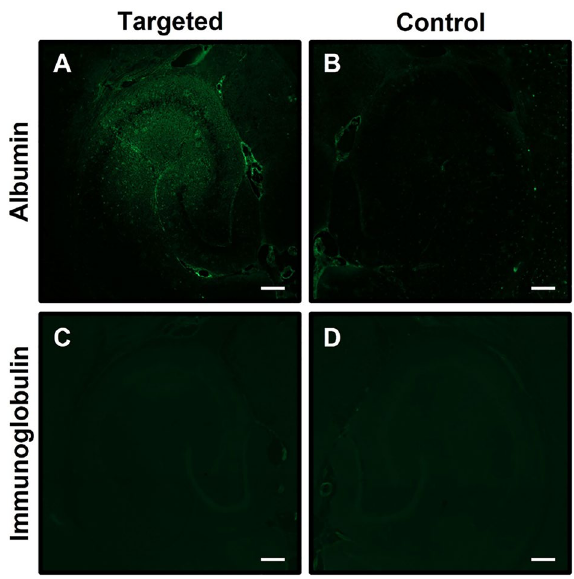
Figure 4. Assessment of endogenous albumin and immunoglobulin extravasation following RaSP treatment at 0.35 MPa. Fluorescence microscopy images of brain slices revealed fluorescence from immunostained endogenous albumin (66.5 kDa) in the ( A ) left hippocampus ROI targeted with RaSP at an acoustic pressure of 0.35 MPa, but not in the ( B ) right hippocampus control ROI of the same brain slice, which was not exposed to ultrasound. No fluorescence from immunostained IgG (150 kDa) was not detected in either the ( C ) targeted left hippocampus or the ( D ) right hippocampus control. Scale bars are 200 µm.